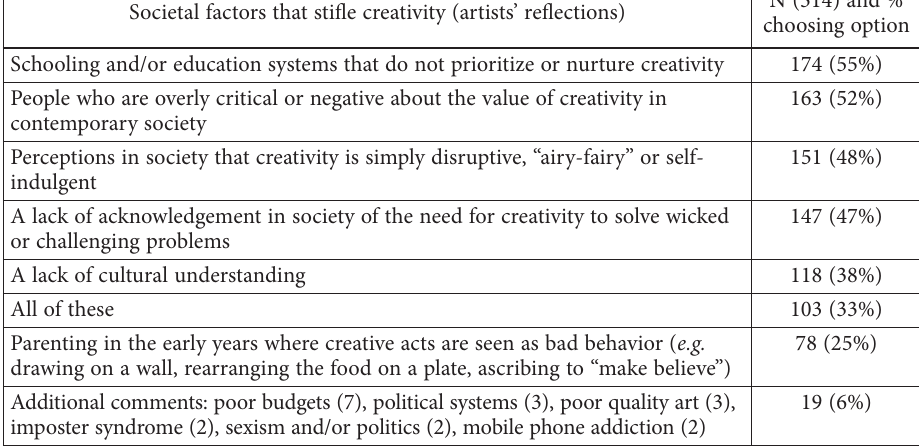
N (314) and % choosing option 163 (52%) 151